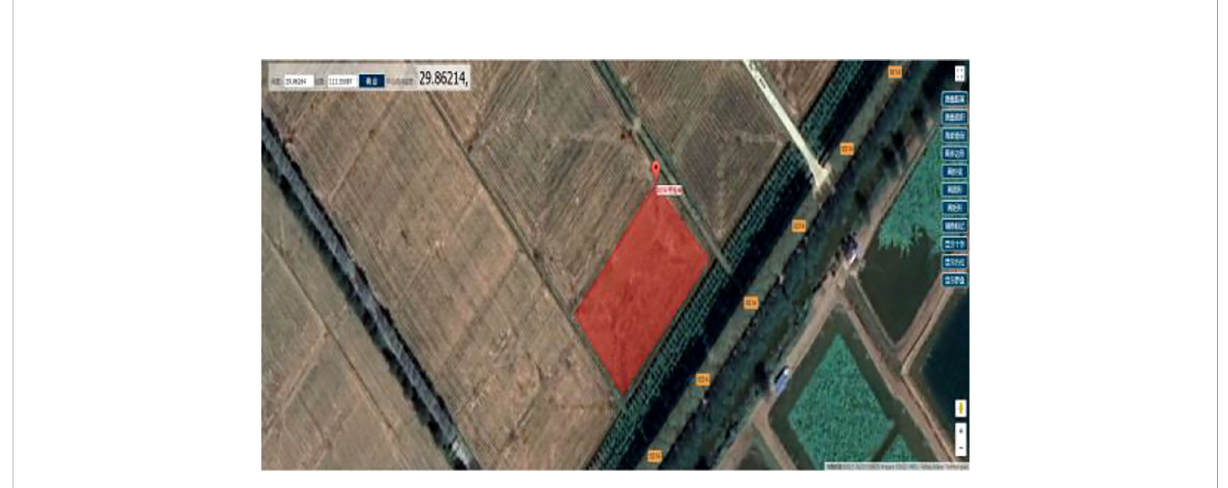
FIGURE 8 Satellite picture of regular fi eld